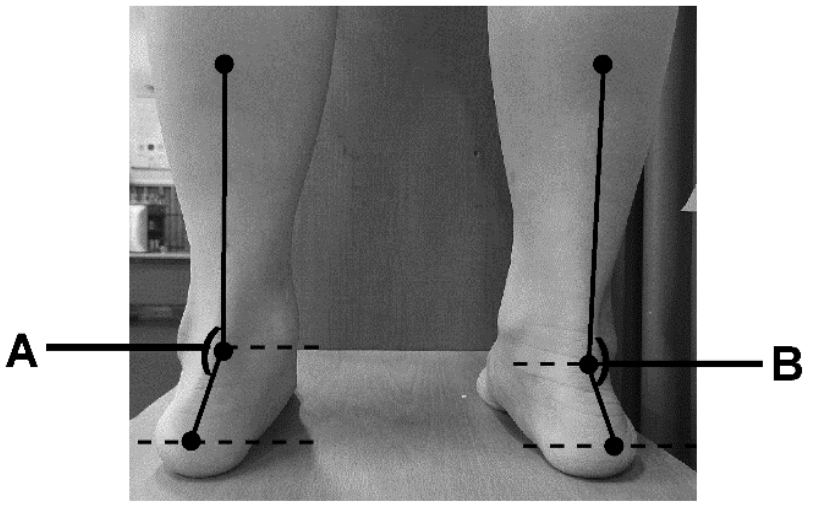
Figure 5. Calcaneal valgus angle measurement [A: Left calcaneal valgus angle (°), B: Right calcaneal valgus angle (°)].